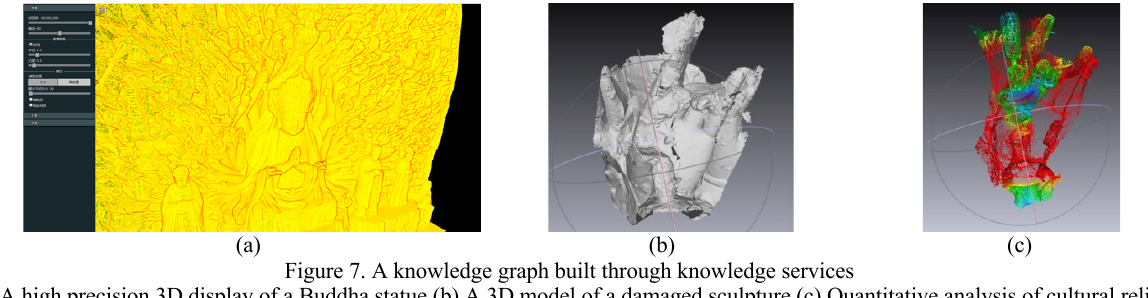
Figure 7. A knowledge graph built through knowledge services